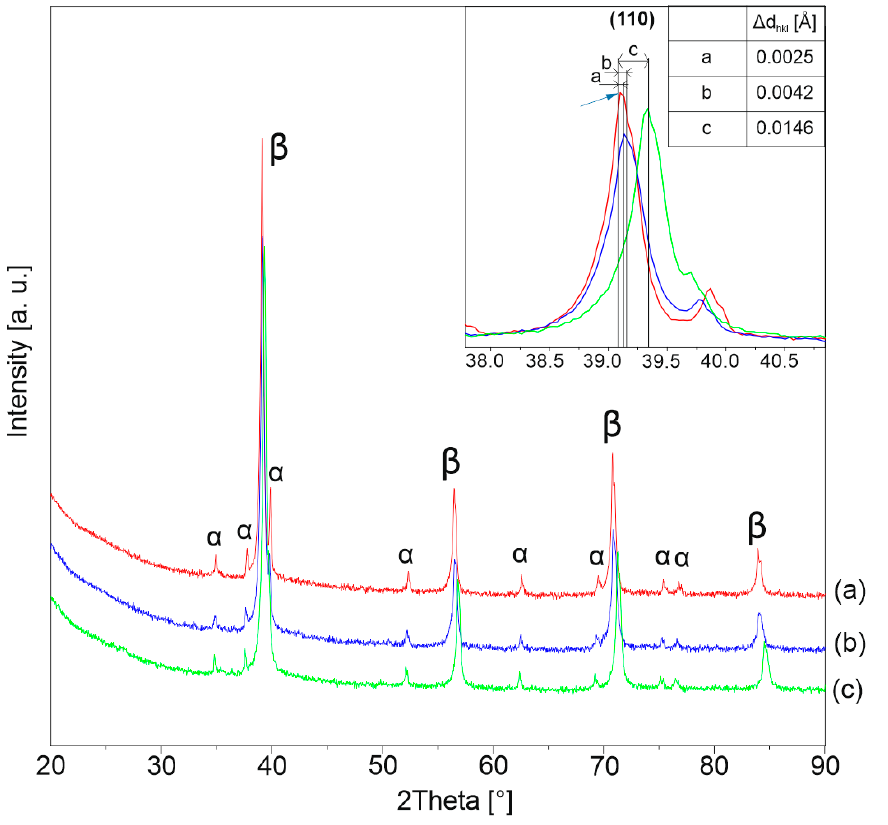
Figure 3. XRD patterns of sintered specimens: ( a ) Ti23Mo, ( b ) Ti27Mo, ( c ) Ti35Mo.